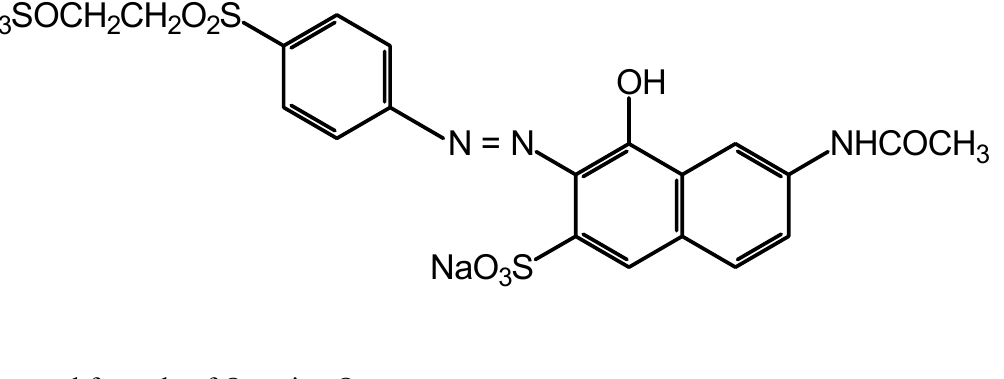
Figure 6. Structural formula of Ostazine